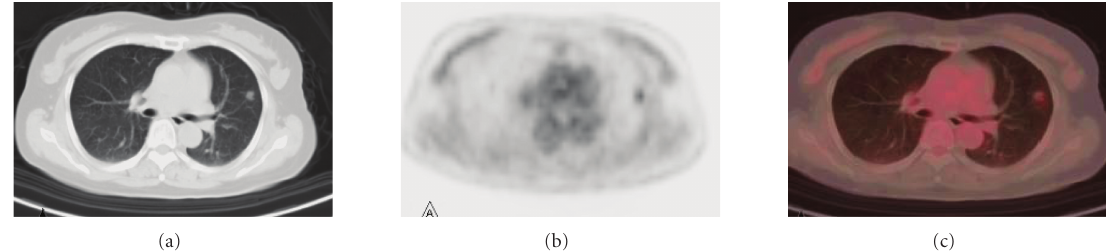
Figure 4: (a), (b), and (c) were from the same patient. The pathological diagnosis is left upper lung adenocarcinoma. On CT, a small module (0 . 9cm × 1 . 0cm) with lobulation and speculated margin was seen in the left upper lung (a). No typical manifestation was seen on PET. The SUVmax of early PET imaging was 1.9 (b). Integrated PET/CT suggested suspected lung carcinoma